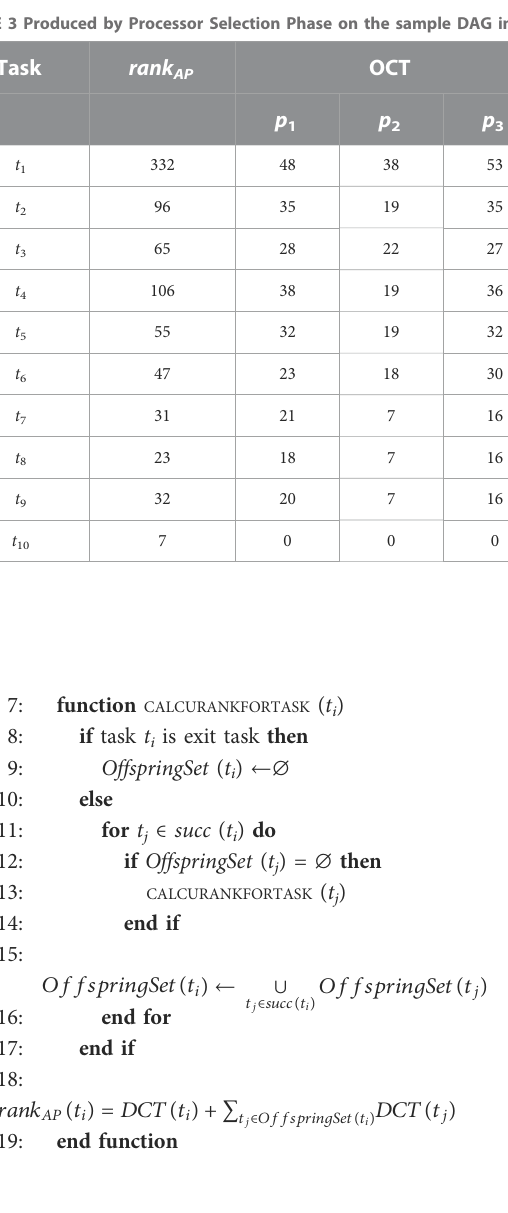
Algorithm 1. Task Priority Calculation